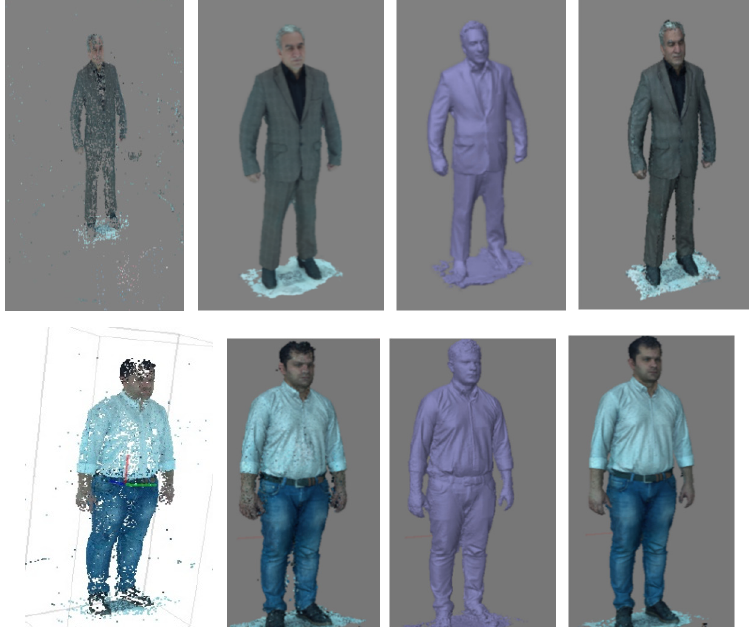
Figure 8. Examples of 3D modeling of the human body. From left to right: Tie-point cloud; dense-point cloud; triangle mesh; 3D model with texture. J. Imaging 2020 , 1 0 , x FOR PEER REVIEW Table 3. Time required for data acquisition by different human body 3D scanners.